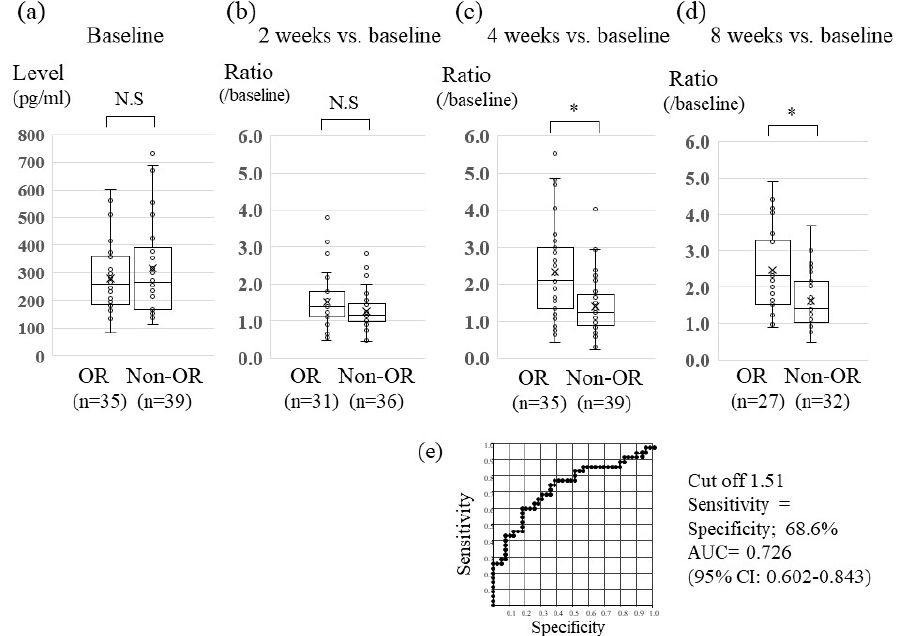
Figure 1. Association between serum FGF 19 levels and lenvatinib treatment response. Distribution of serum fibroblast growth factor (FGF) 19 levels at baseline ( a ), and the ratio versus baseline of FGF19 levels at 2 weeks ( b ), 4 weeks ( c ), and 8 weeks ( d ) between the OR (objective response) and non-OR groups. Data are shown as median values (10th–90th percentile ranges). The Mann-Whitney or Kruskal-Wallis test was used to determine statistical signi ficance. * p < 0.05, N.S: non-significant. ( e ) Receiver-operating characteristic curve (ROC) analyses of the ratio of FGF19 at 4 weeks versus baseline for differentiating patients in the OR group versus the non-OR group. AUC, area under the ROC curve.